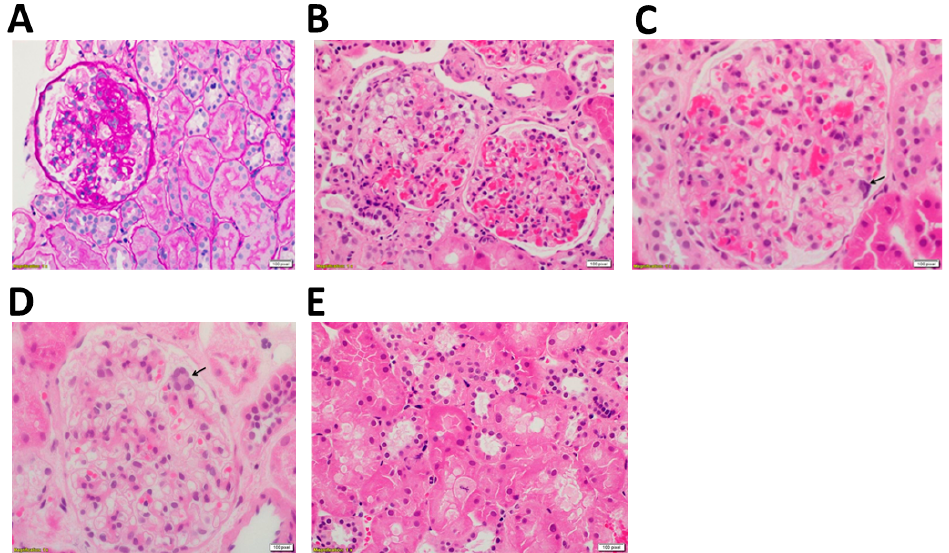
Figure 1. Histopathological manifestations in the patient. ( A ) Glomerulus shows signs of focal segmental glomerulosclerosis, which was likely due to podocytopathy, secondary to renal cystinosis. ( B ) Hyperplasia and cytoplasmic foam cell change in the glomerular visceral epithelial cells (arrow) were identified. ( C , D ) In the glomerular epithelium, few multinucleated podocytes were found (arrows). ( E ) Hydropic epithelial cells with pale eosinophilic cytoplasm and foamy change were observed in the kidney tubule. (( A ) Periodic acid Schiff (PAS) 200×, ( B ) Hematoxylin and Eosin (H&E) 200×, ( C – E ) H&E 400×).